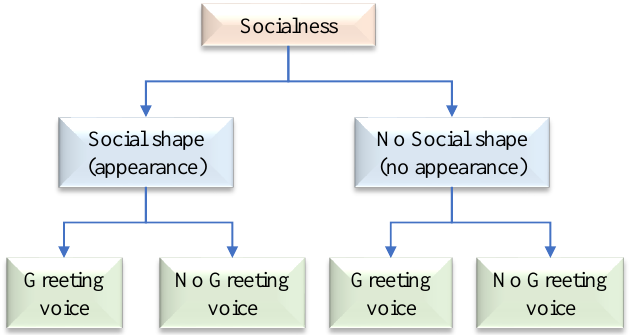
Figure 7. The taxonomy of cases considered in the study